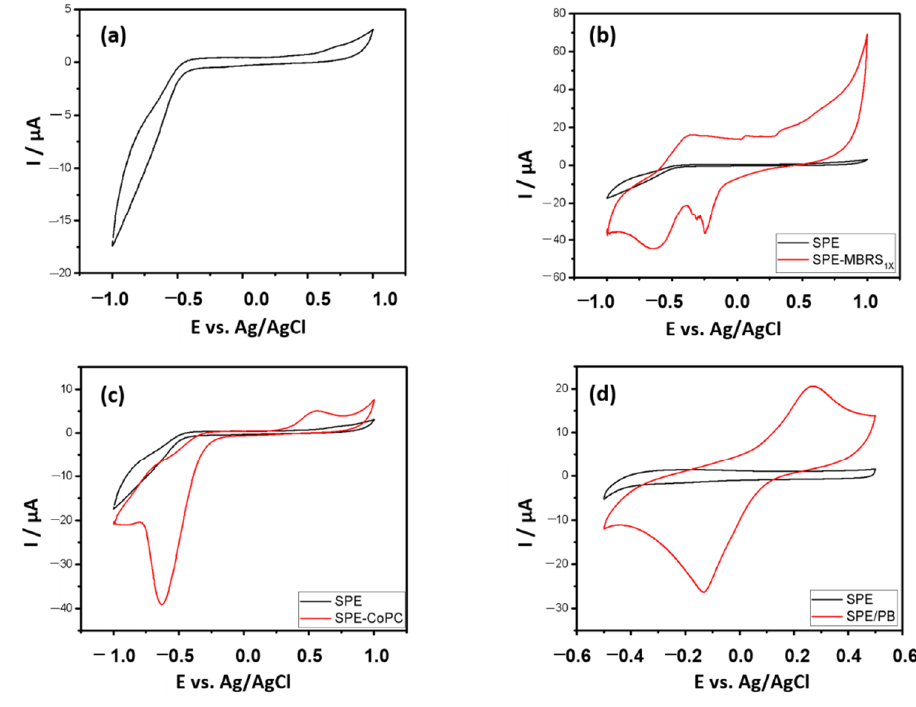
Figure 1. Principle of detection using XOD based biosensor, using Prussian Blue (PB), as